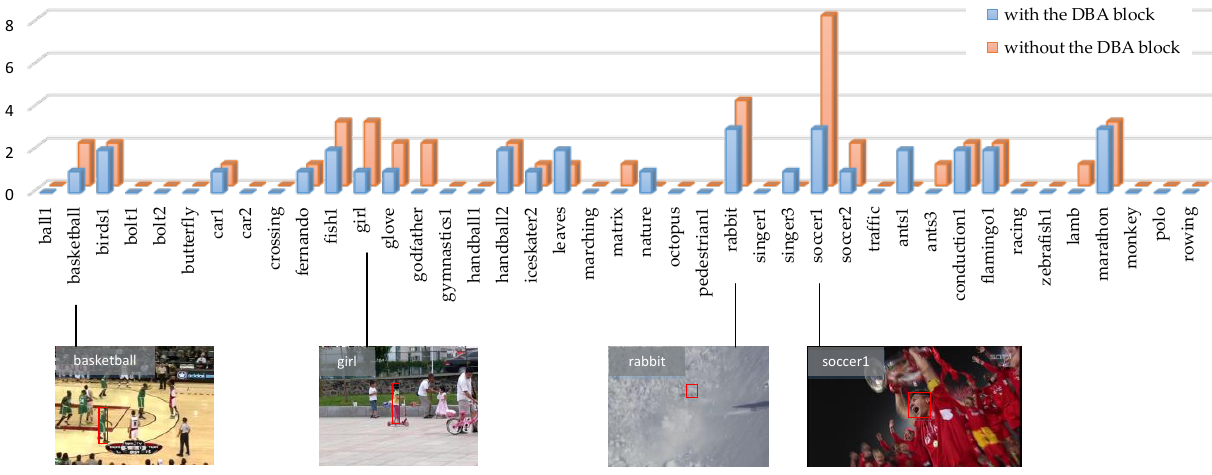
Figure 3. The number of lost frames of OPE on challenging video sequences.